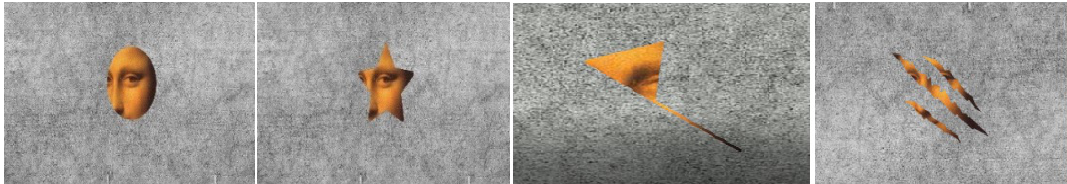
Figure 5. Erasure animations with different erasure shapes.